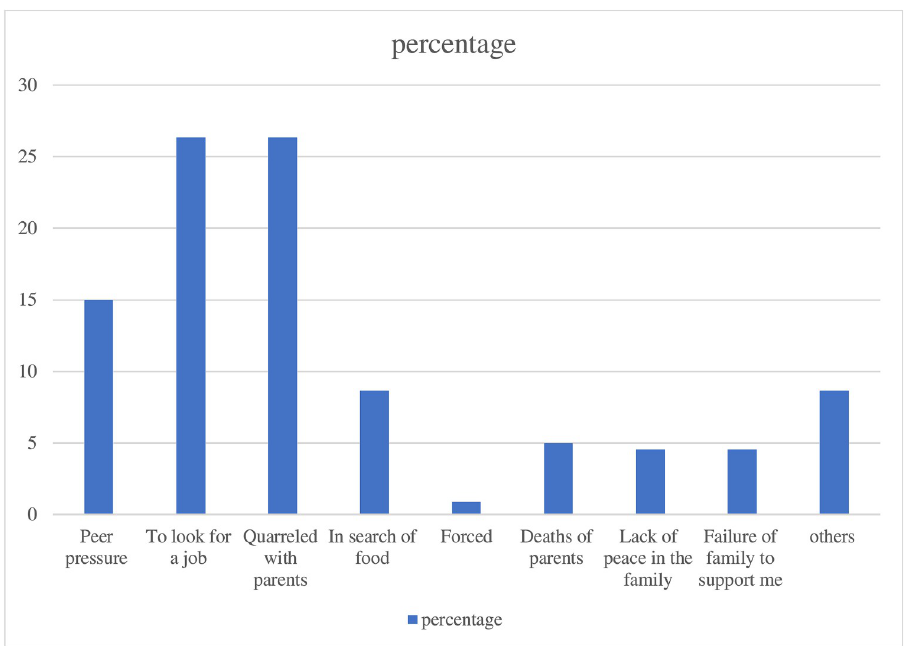
Fig 2. Factor that forced the street children to live in the street in Harar, Ethiopia,